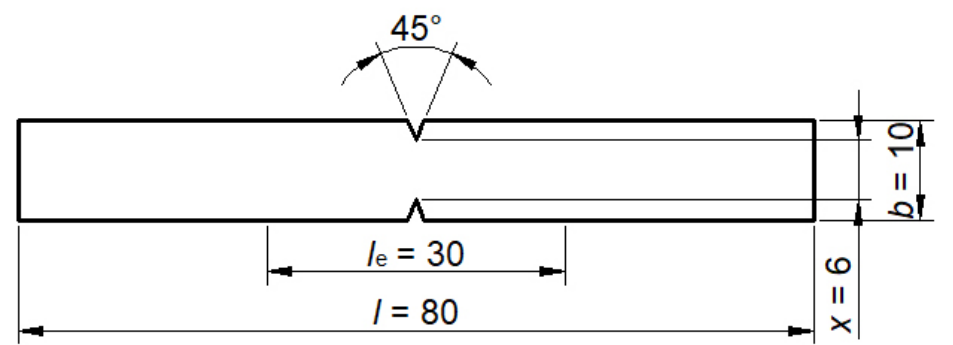
Figure 3. Test specimen for testing tensile-impact strength [18].